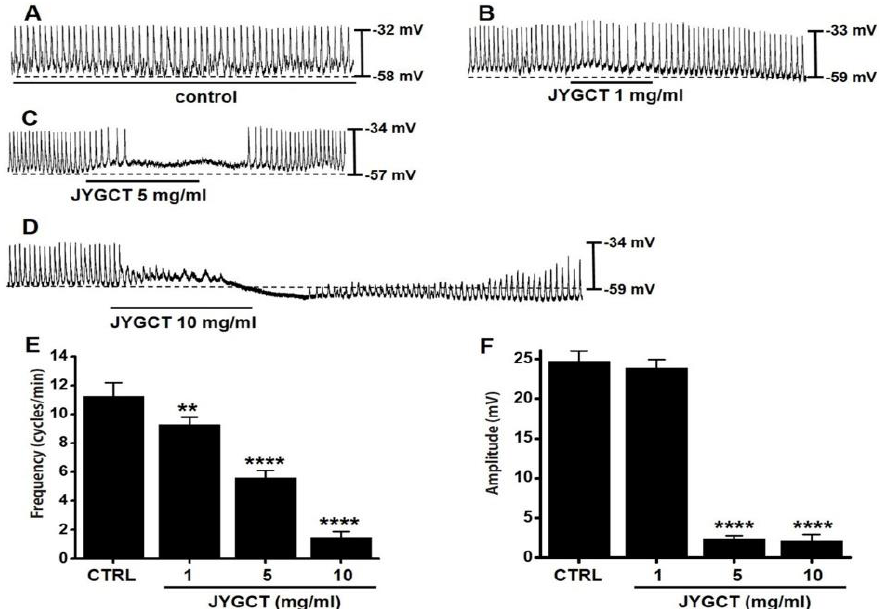
Figure 1. Effect of JYGCT on the pacemaker potential in the ICC. ( A – D ) JYGCT inhibited the pacemaker potential; ( E , F ) Summary of the inhibitory frequency and amplitude effects of JYGCT on the pacemaker potential in the ICC. Bars represents the mean ± SE. ** p < 0.01. **** p < 0.0001. JYGCT: Jakyakgamcho-tang; CTRL: control.